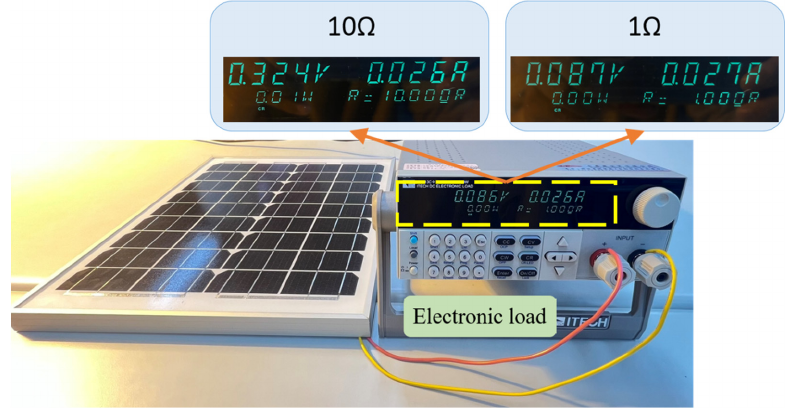
Figure 4. A poor connection of a PV module .